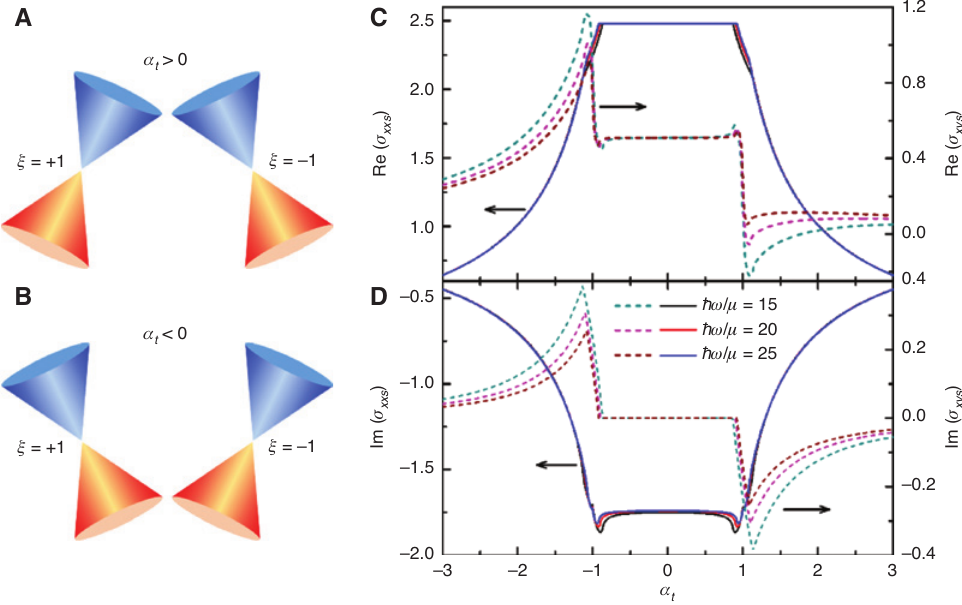
Figure 2: Tilted Weyl nodes and optical conductivity spectra. Tilted conical spectra of a pair of Weyl nodes for (A) α lines) and σ (dashed lines). The conductivities are all scaled in the unit of σ xys